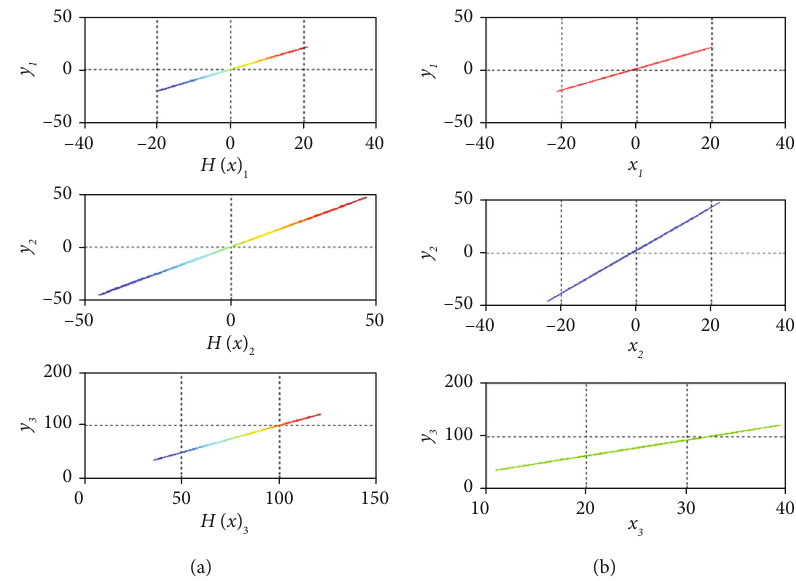
Figure 1: The synchronization relationships of di ff erent state variables in the unidirectionally coupled Chen system. (a) H ð x Þ = ð H ð x Þ Þ T and y = ð y , H ð x Þ , H ð x Þ 1 2 3 synchronization with respect to the linear manifold y = Px + Q .